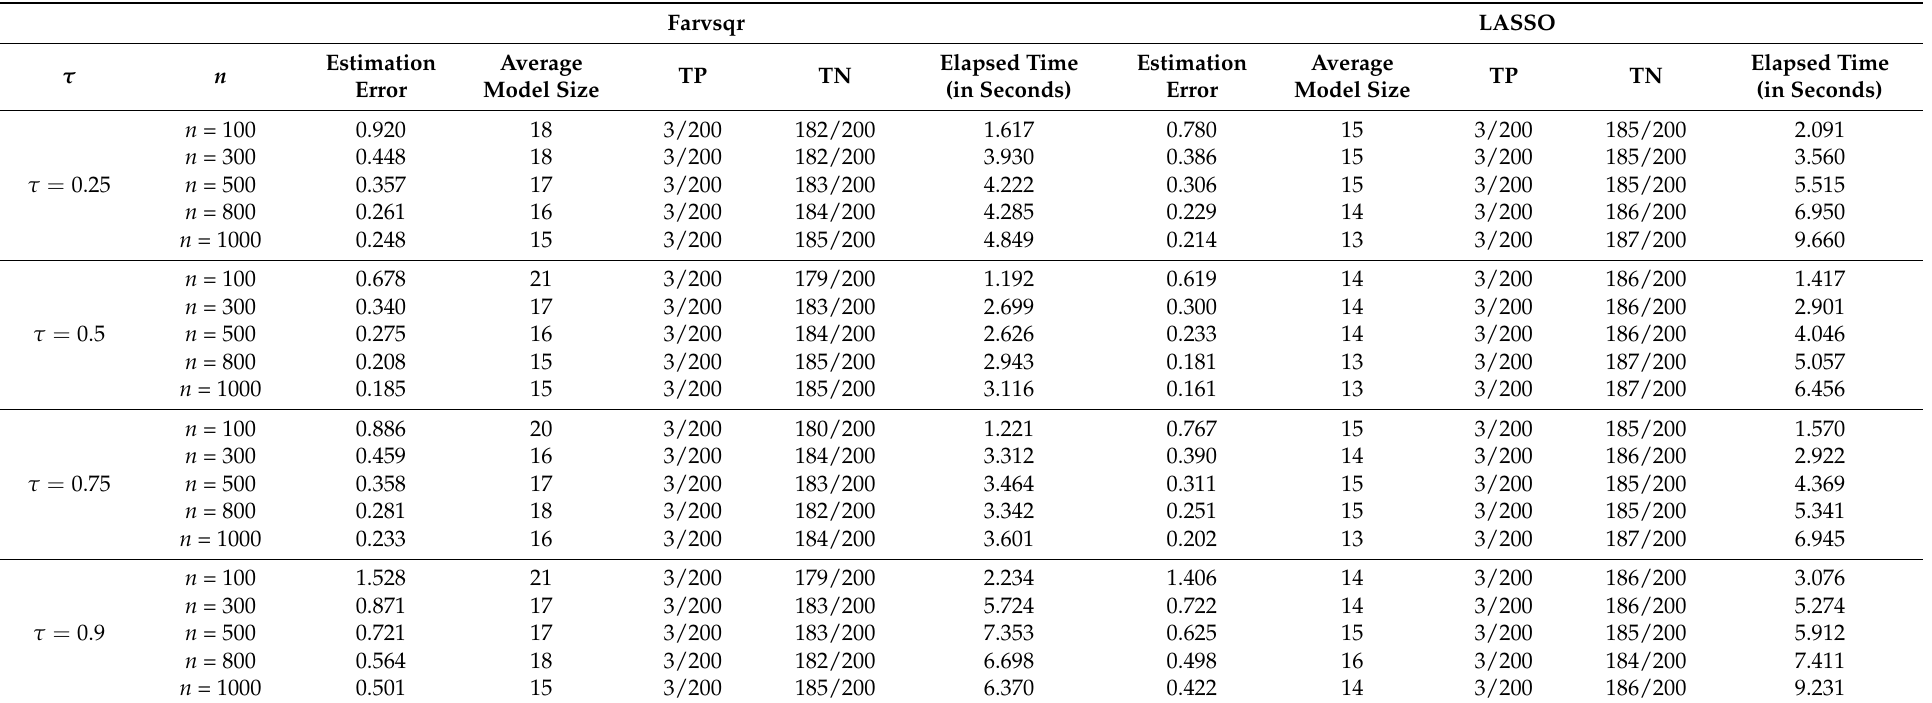
Table 8. The comparison for p = 200, t 2 with the equal correlated case. Farvsqr